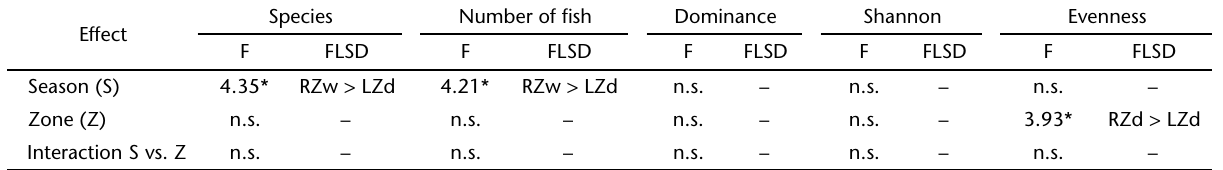
Table III. Two-way analysis of variance comparisons for number of species, individuals, Dominance, Shannon and Evenness indices among zones: (RZ) riverine zone, (TZ) transition zone, (LZ) lentic zone, and seasons: (w) wet, (d) dry. (FLSD) Test of Fisher, (n.s.) no significant, (*) significant (p <